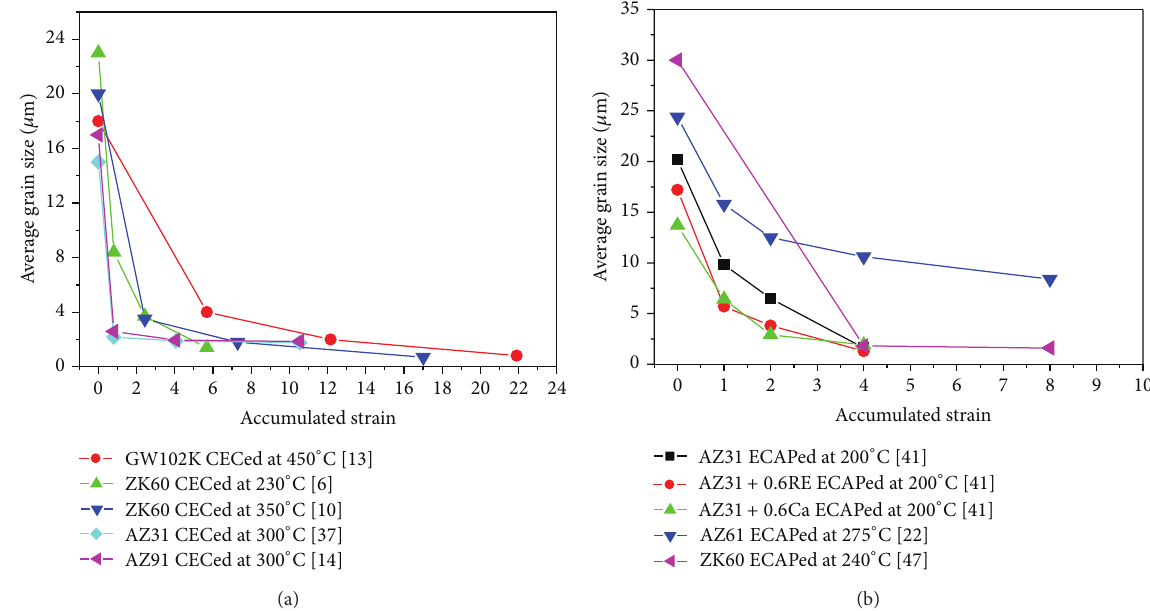
Figure 3: Grain size of Mg alloys as a function of the accumulated strains of (a) CEC and (b)